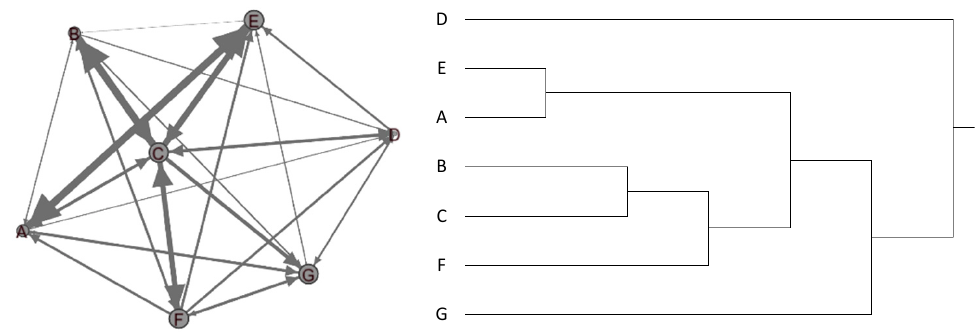
Figure 5. A sociodiagram (left) and hierarchical clustering (right) of the Befriending program.